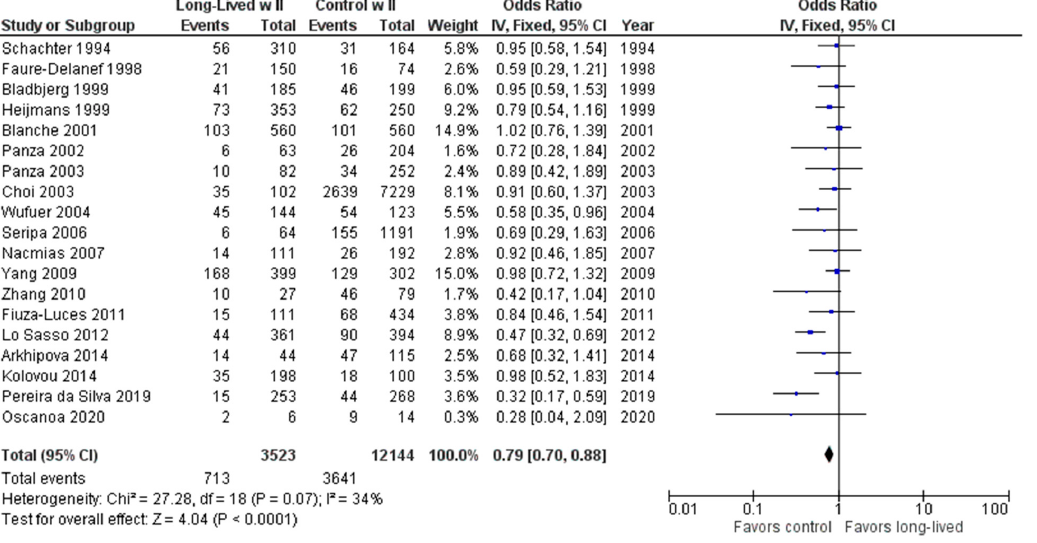
Figure 7. Comparison of II genotype frequency in long-lived and control groups. The ages of long-lived and control groups are described in Table 1. The p- value is indicated by P in the Figure.